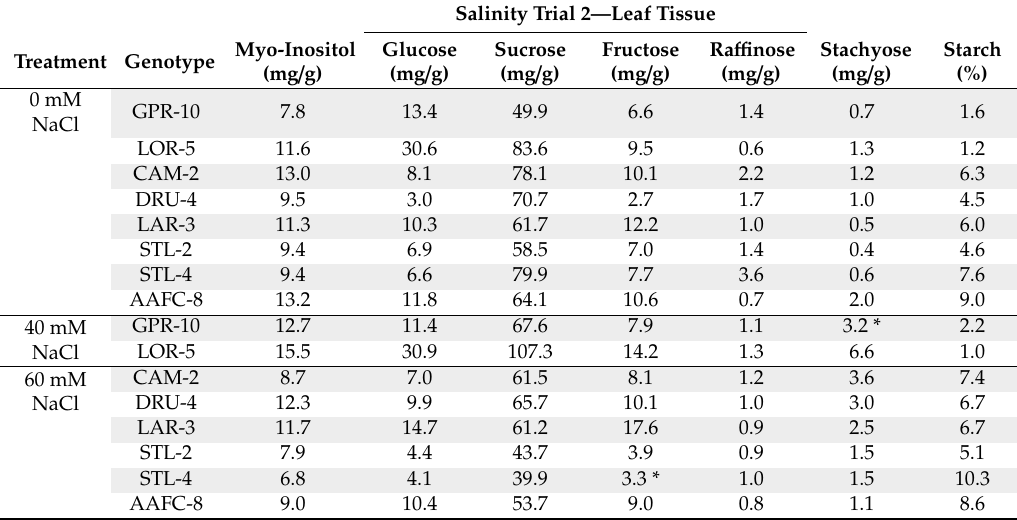
Table 3. Soluble sugar and starch contents in poplar, willow, hybrid willow leaf tissues at the conclusion of the second salinity trial. Willow and hybrid leaves were analyzed at 0 and 60 mM NaCl, and poplar leaves at 0 and 40 mM NaCl due to lack of available leaf tissue ( n = 3 for each genotype and treatment). Asterisks denote significant di ff erence from control treatment ( p < 0.05). One sample outlier was removed for DRU-4 glucose in the high fracking wastewater